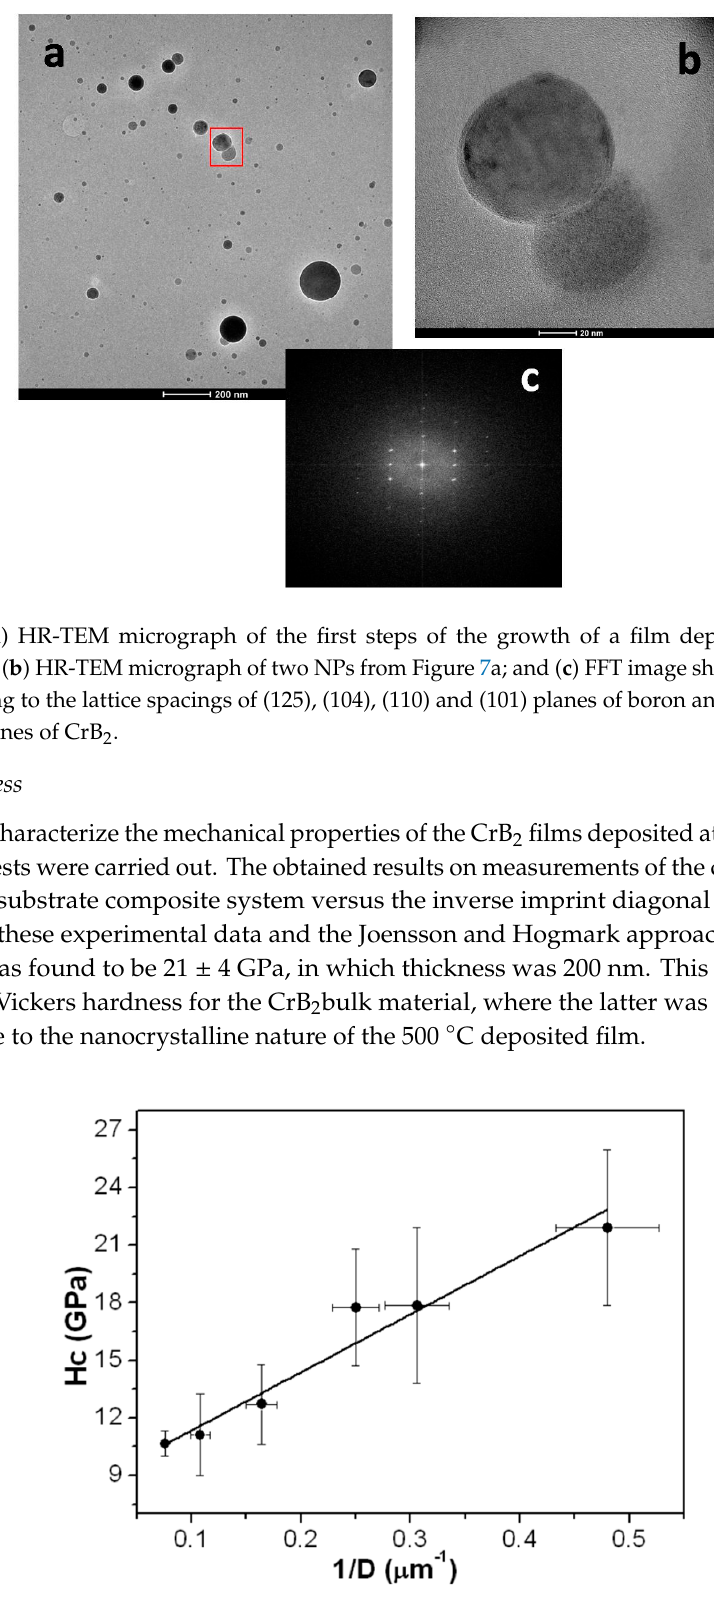
Figure 7. High-magnification FESEM micrograph of films deposited from a target with a Cr-B molar ratio of 1:4 at a substrate temperature of 500 °C.